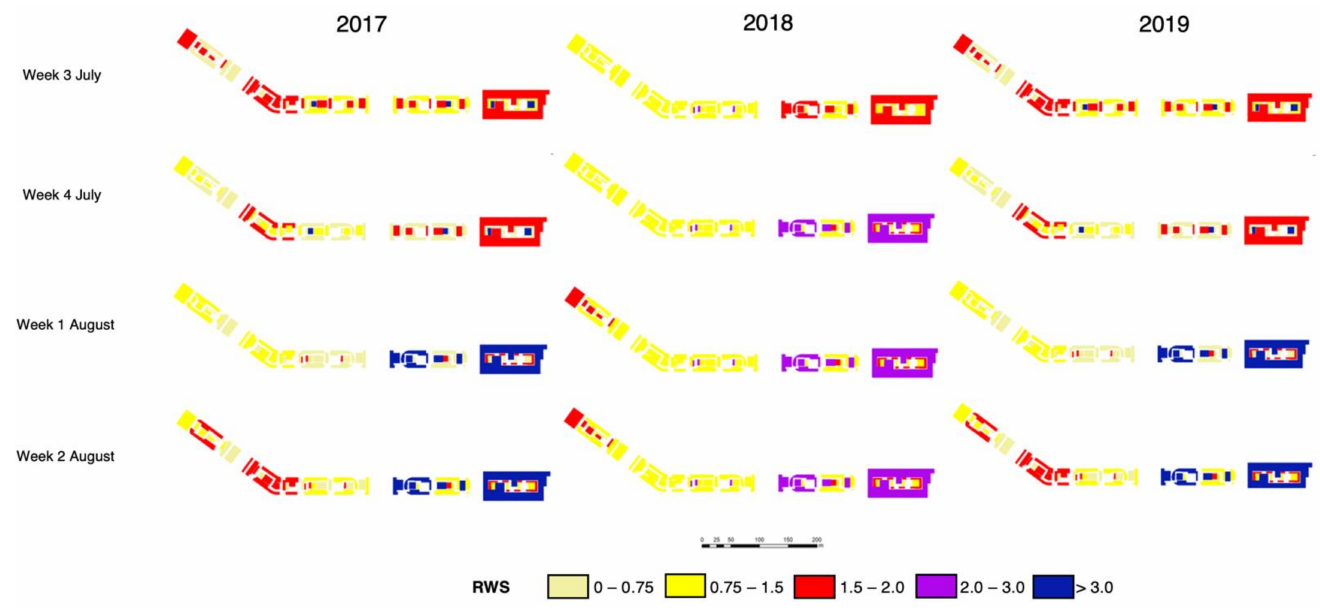
Figure 8. RWS maps for parks 301, 302, and 303 (0.75 < RWS < 1.5, optimal